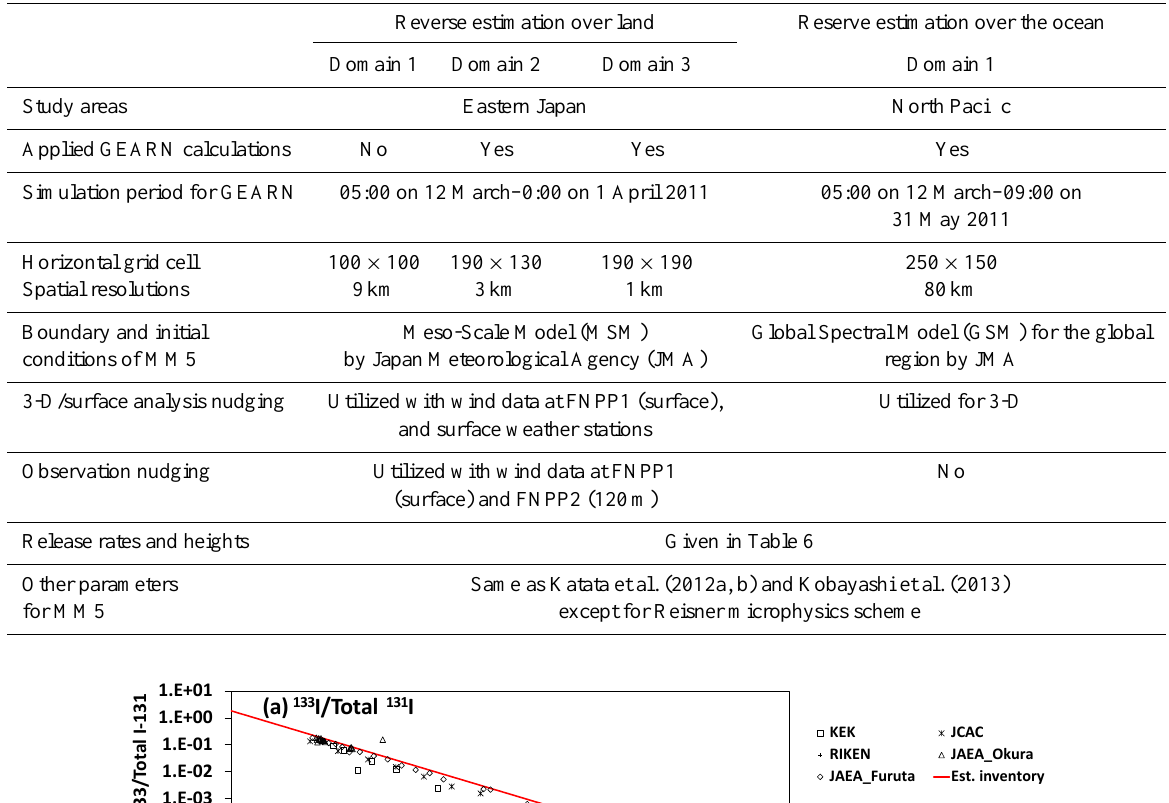
Table 4. The settings for the WSPEEDI-II atmospheric dispersion model used in the coupling of the atmospheric and oceanic dispersion simulations.